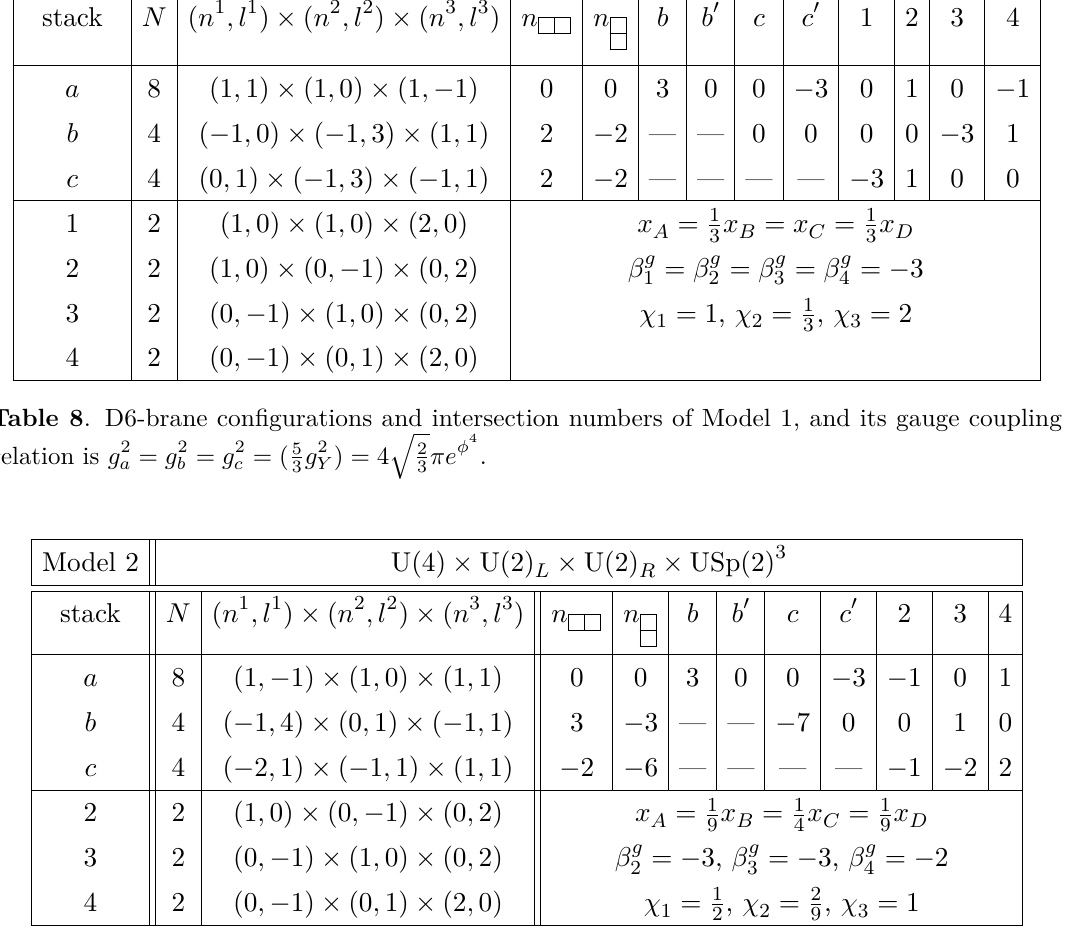
Table 9 . D6-brane configurations and intersection numbers of Model 2, and its MSSM